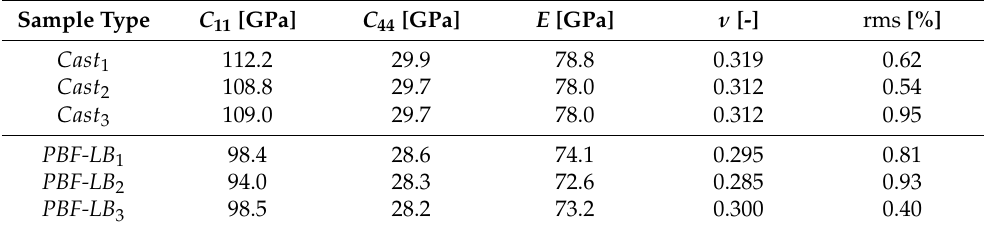
Table 4. Results from the RUS